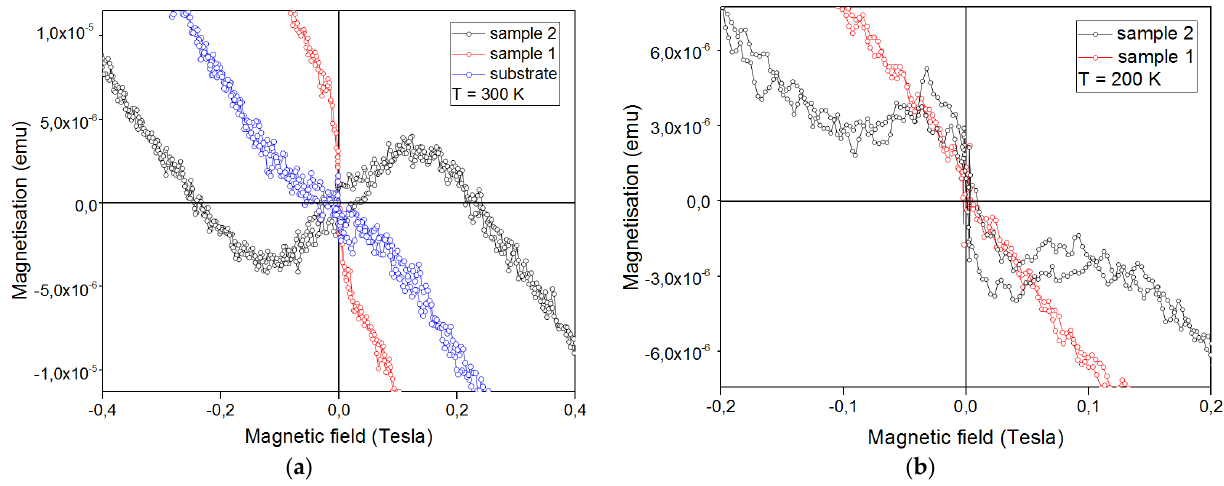
Figure 10. Magnetic hysteresis loops M (H) for BFO/polyimide samples at ( a ) 300 K and ( b ) 200 K.